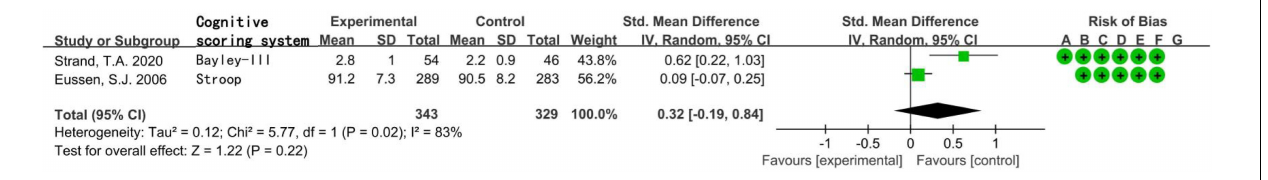
FIGURE 4 | Forest plot of the association between MMA and cognition in the two randomized controlled studies.